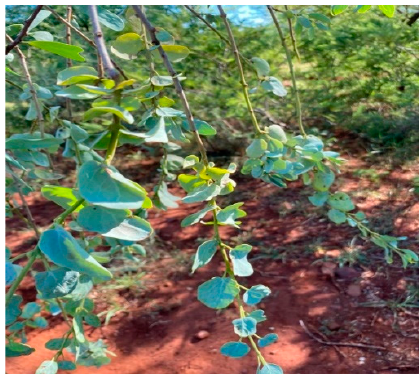
Figure 1. Viscum rotundifolium in Limpopo Province, photo taken by KE Ravhuhali. Table 1. Viscum species and their distribution.